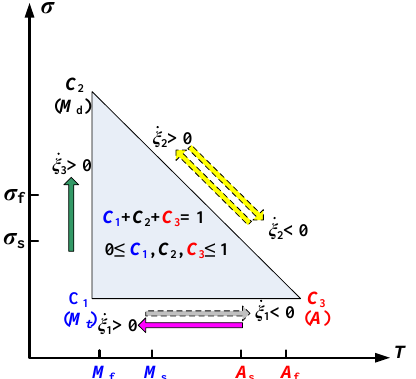
Figure 1. Schematic of phase transformation among three types.